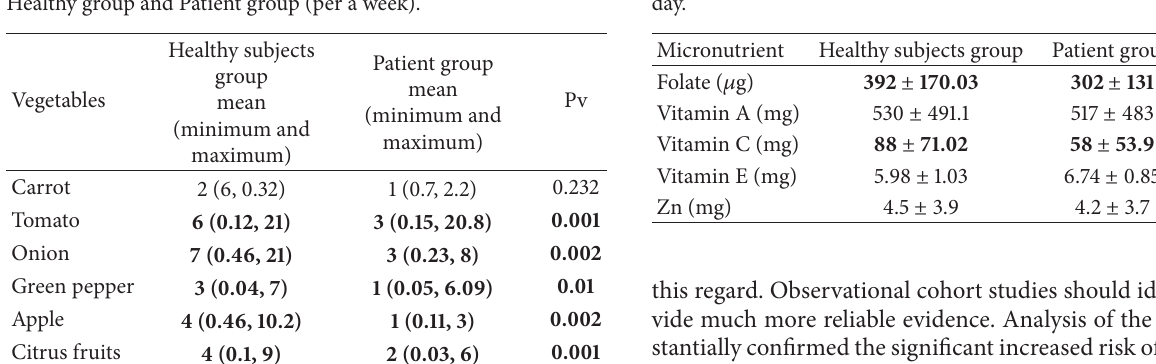
Table 3: Food frequency data of Fruits and vegetables intakes of Healthy group and Patient group (per a week).